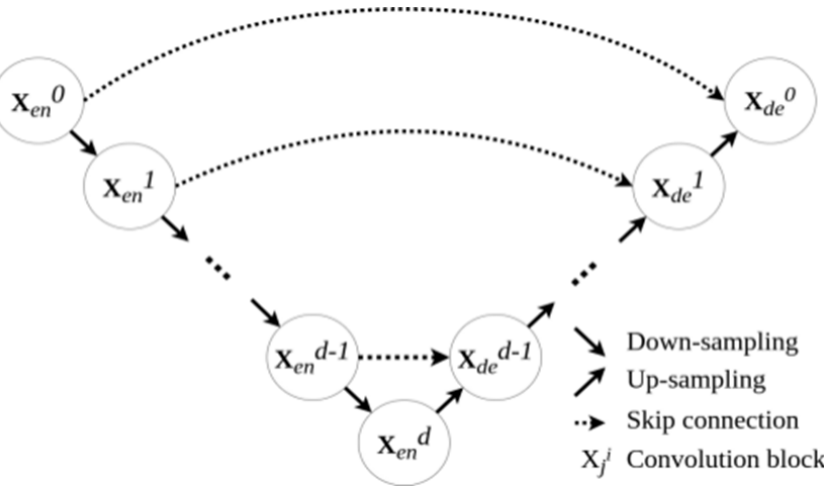
Figure 10. The U-Net architecture ( X en is the encoder block, X de is the decoder block). The standard U-Net scheme consists of the encoder part (convolution part) and decoder part (deconvolution part). At the same time, each block of the decoder of the U-Net network is implemented from the so-called pairwise convolutional layers with joint activation [11]. This provides (in contrast to the feedforward-based architectures) features to transfer from the encoder block to the corresponding decoder block. Moreover,